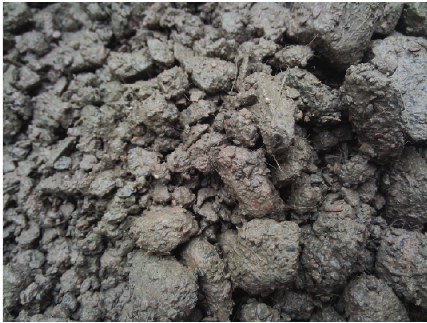
Figure 4: The mixing quality of CSM mixture.